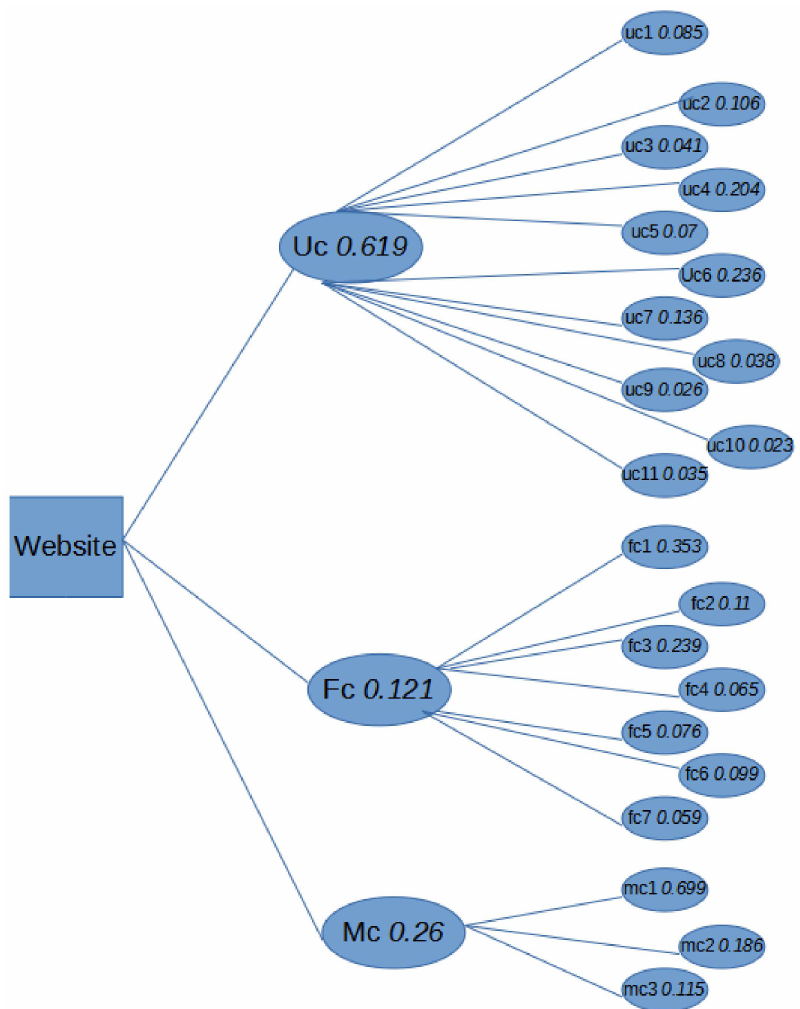
Figure 1. Hierarchy of dimensions and criteria as well as their weights of importance according to